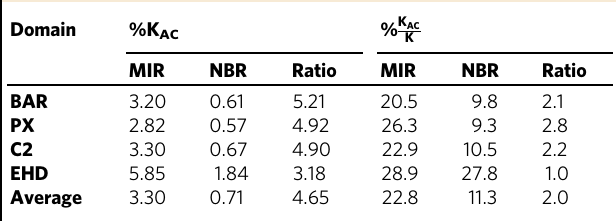
Table 1 Prevalence of lysine acetylation in membrane- interaction regions and non-binding regions of BAR, PX, C2 and EHD membrane-binding domains.